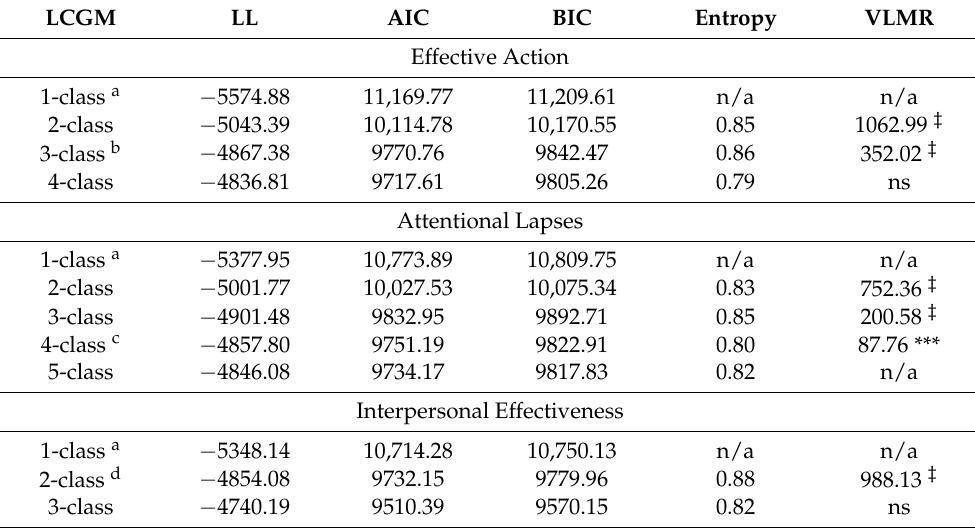
Table 2. Fit Indices for Effective Action, Attentional Lapses, and Interpersonal Effectiveness Subscales of the Attentional Function Index Based on LCGA solutions for Seven Assessments of Patients with Breast Cancer From Prior to Through to 6 Months After Surgery.